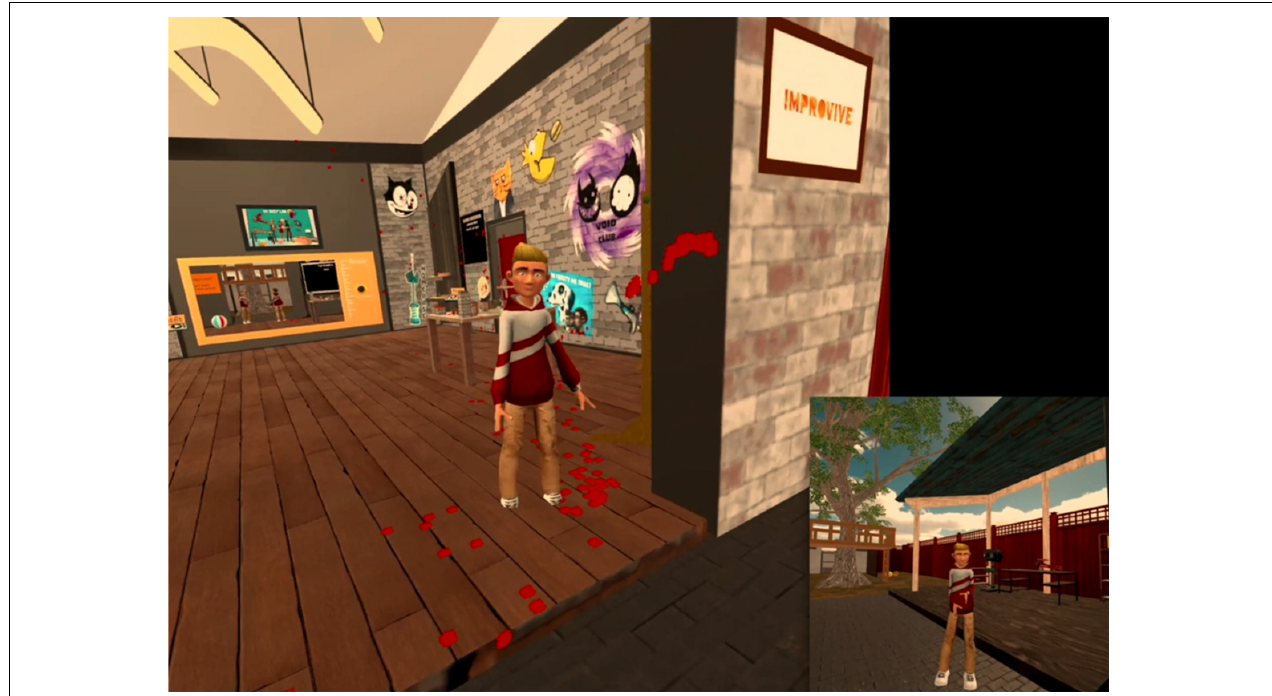
FIGURE 1 | The virtual arts & psychomotor therapy space “VR Health